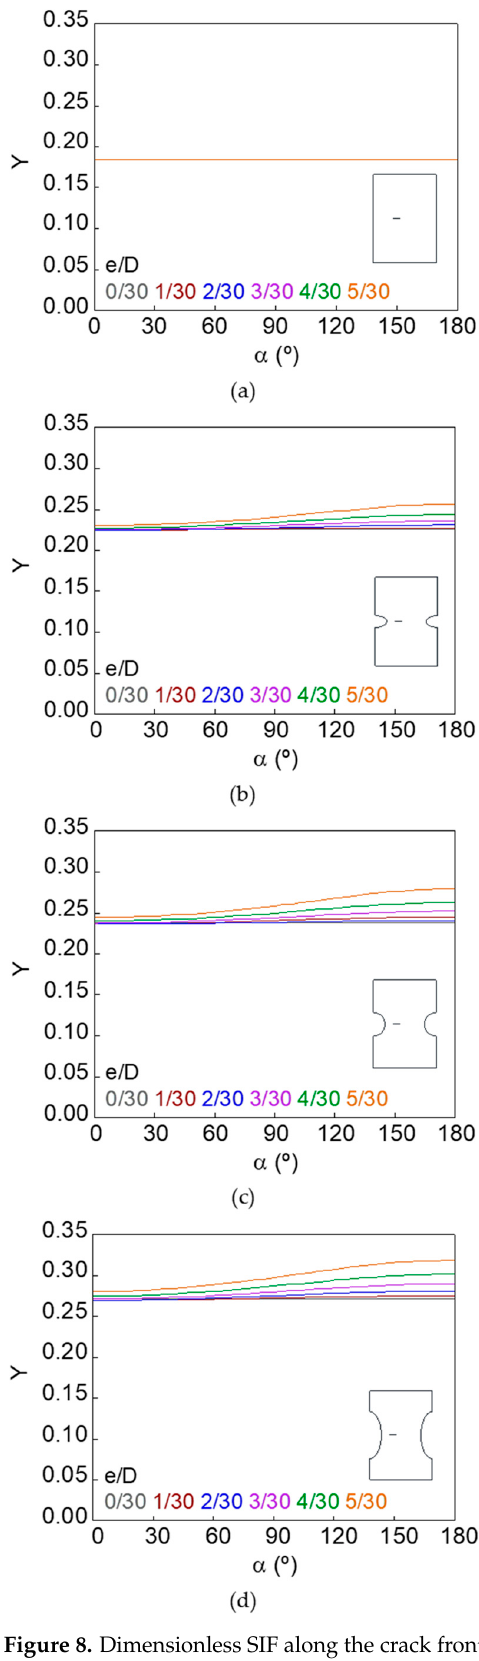
Figure 8. Dimensionless SIF along the crack front, d / D = 5/30: ( a ) smooth bar; ( b ) sharp notched bar; ( c ) circular notched bar; ( d ) blunt notched bar.